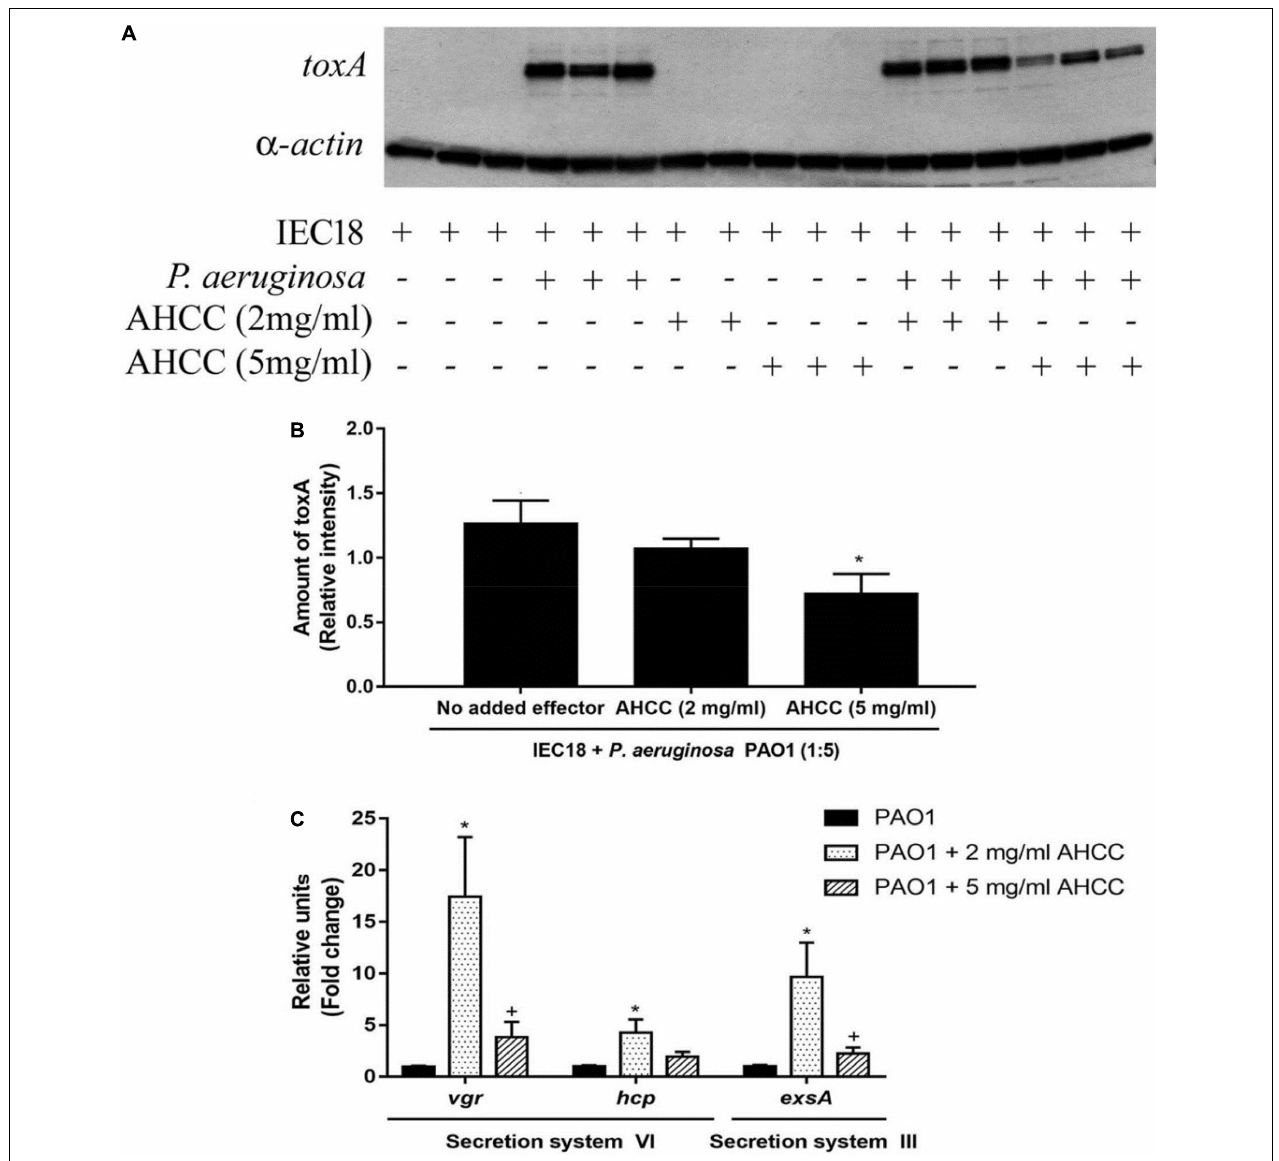
FIGURE 6 | The gene expression of P. aeruginosa secretion systems and toxA are modulated by AHCC R (cid:13) . (A) Western blot determination of the cellular concentration of exotoxin A in IEC18 cells following co-culture with P. aeruginosa in the presence and absence of AHCC R (cid:13) at 2 and 5 mg/mL of concentration. (B) Densitometric analysis of above data. Exotoxin A densities were corrected with those obtained for α -actin. (C) Quantitative real time PCR studies of P. aeruginosa of cultures grown in the presence and absence of AHCC R (cid:13) at 2 and 5 mg/mL of concentration. The expression of genes encoding proteins of secretion systems III and VI are shown. Values are means ± S.E.M., n = 6–9; * p < 0.05 vs. without AHCC R (cid:13) (ANOVA followed by least significance